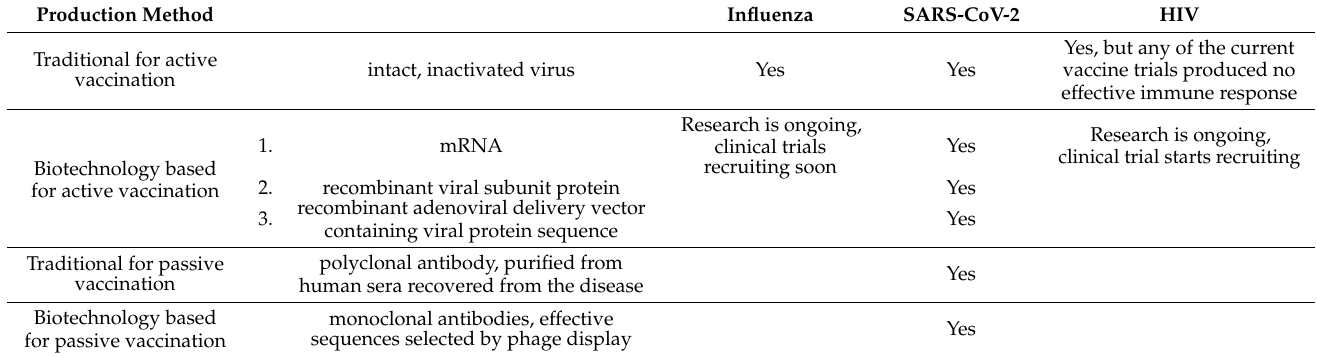
Table 3. Vaccine